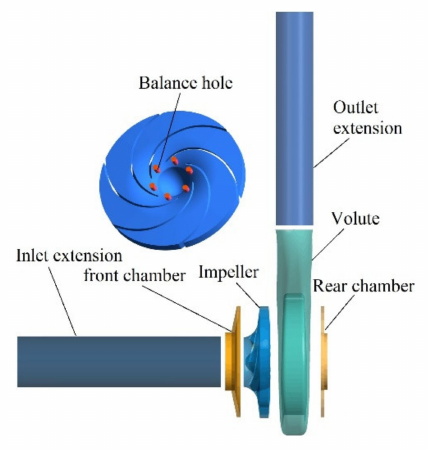
Figure 1. The solid model of centrifugal pump.